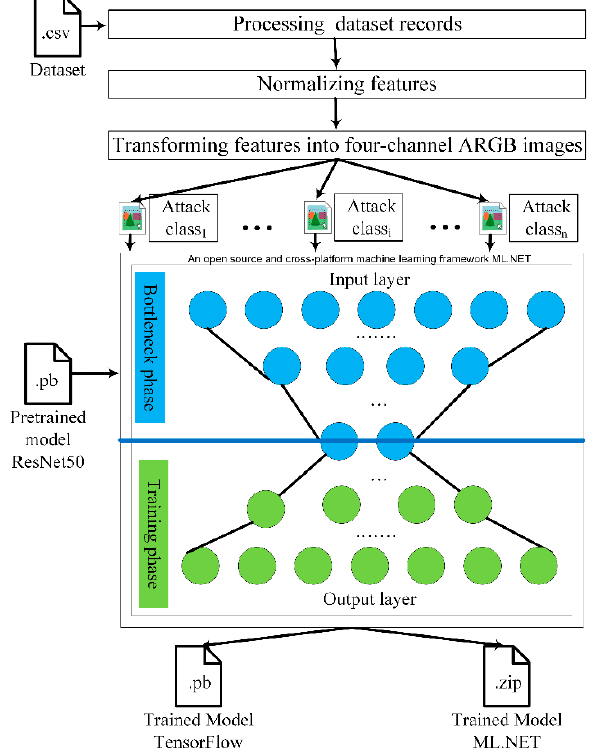
Figure 3. Proposed approach for network intrusion detection using multistage deep learning im- age recognition.